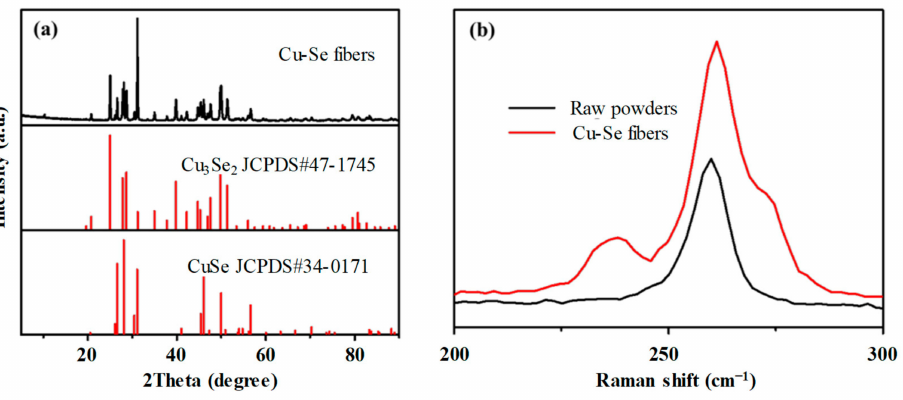
Figure 2. ( a ) X-ray diffraction spectra of the Gu-Se core fiber; and ( b ) Raman spectra of the Gu-Se raw powders and